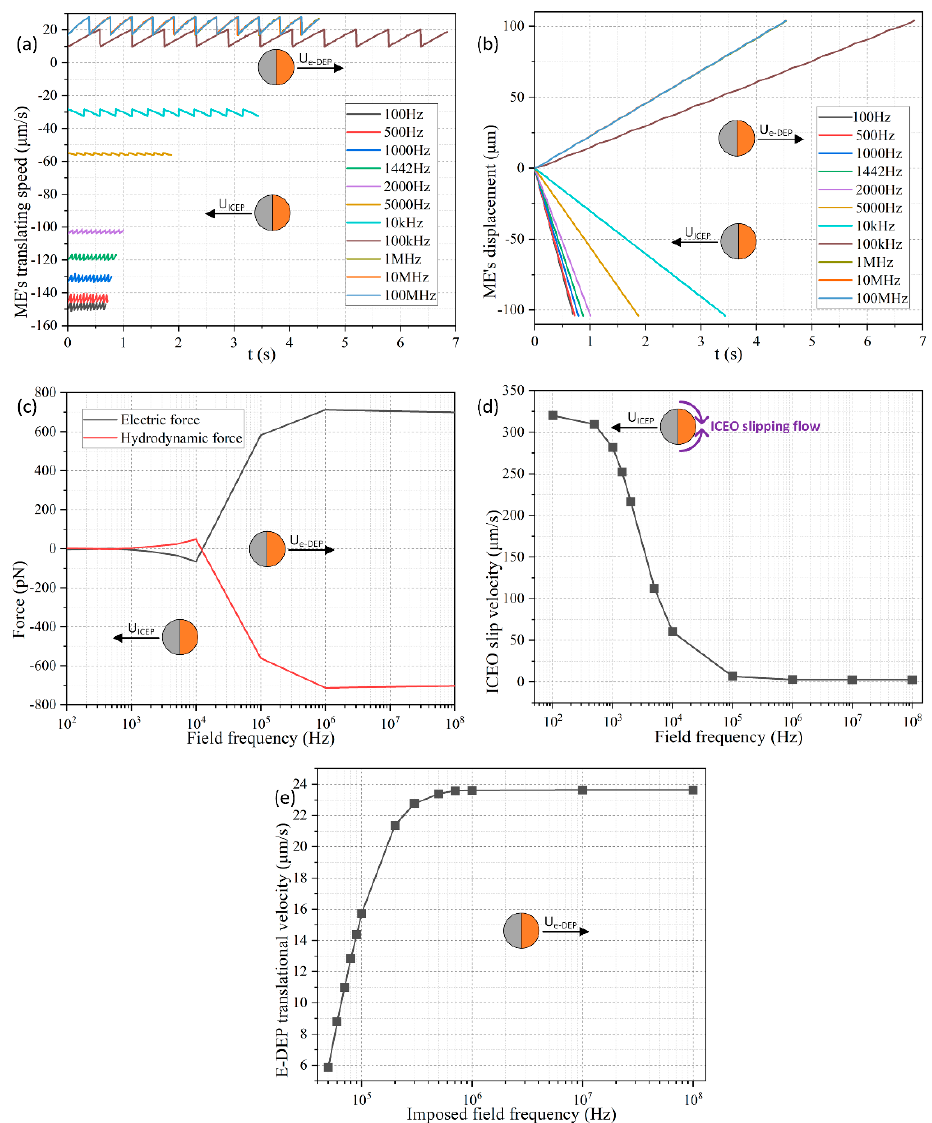
Figure 3. Influence of the imposed AC field frequency on the electrokinetic transportation behavior of an individual Janus ME with a diameter of 12 µ m. ( a ) Time-dependent ME’s translating speed under di ff erent signal frequencies for a same total displacement of 105 µ m. ( b ) The horizontal displacement of the Janus colloid as a function of time in a wide frequency range. ( c ) The balance between the electric force and hydrodynamic force acting on the Janus entity as a function of the field frequency. ( d ) Frequency-dependent ICEO slipping velocity on the surface of the conducting end. ( e ) e-DEP-induced JP translating speed as a function of the imposed field frequency from 50 kHz to 100 MHz. It is noteworthy that ICEP dominates in the frequency range below 50 kHz, so the start threshold frequency is set at 50 kHz in Figure 3e.